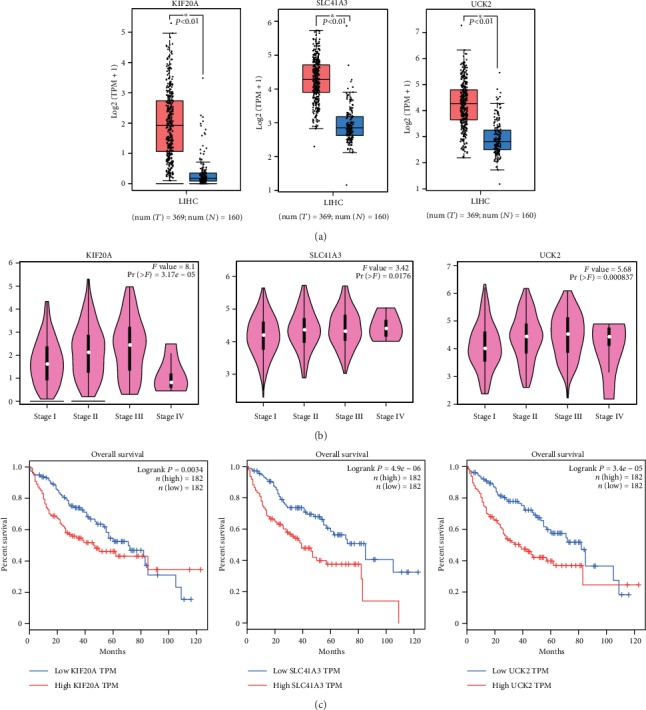
The prognostic value of KIF20A, SLC41A3, and UCK2. (a) Comparison of AATF expression between HCC and ANTT. (b) Comparison of AATF expression among different pathological stages. (c) Relationship between the expressions of KIF20A, SLC41A3, and UCK2 and the prognosis of HCC patients in the TCGA dataset. P value was calculated using the log-rank test and shown on the top right corner. ANTT: adjacent nontumor tissues.